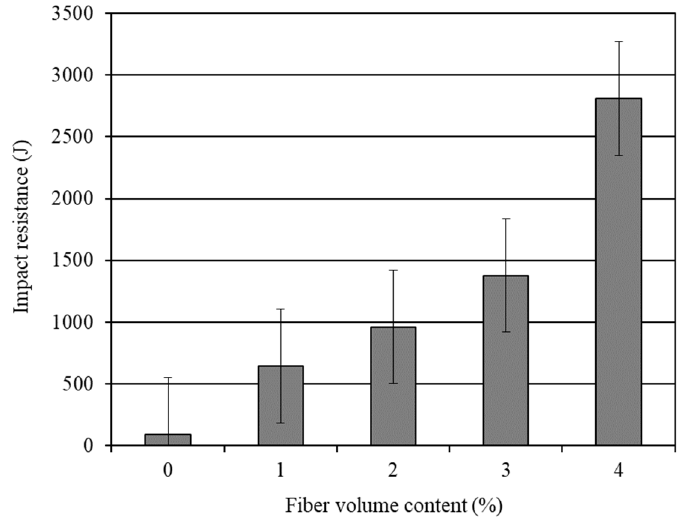
Figure 3. Influence of carbon fibers on the 28-day impact resistance of mortar composite.